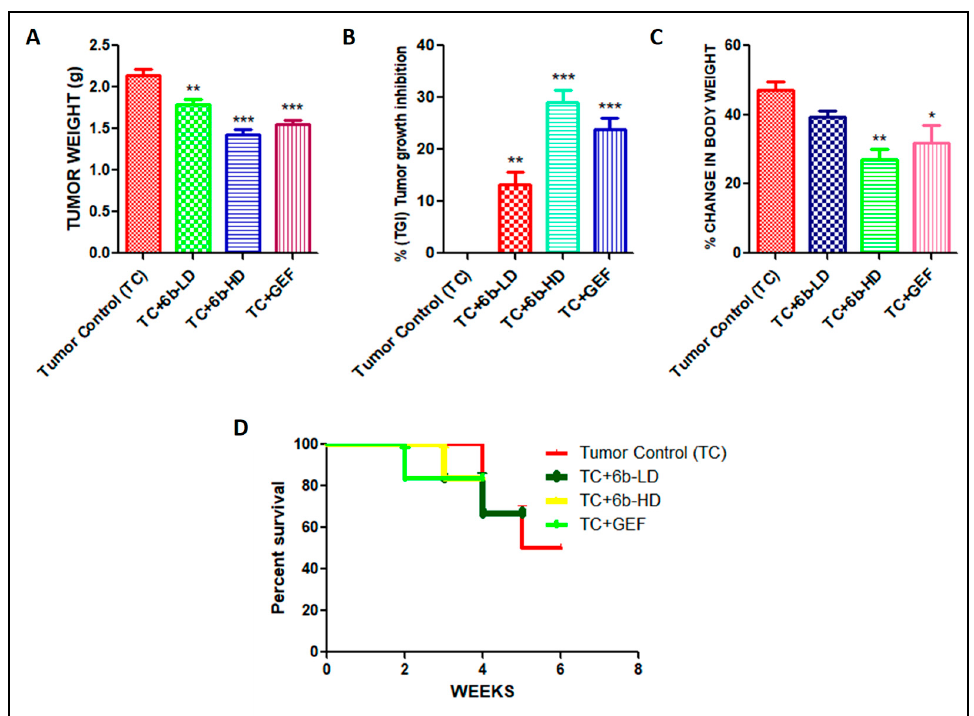
Figure 2. Effect of 6b and gefitinib treatment on the ( A ) tumor weight (g), ( B ) % tumor growth inhi- bition (TGI), ( C ) % body weight change, and ( D ) survival rate. All values are expressed as mean ± S.E.M. * p < 0.05, ** p < 0.01, *** p < 0.001 significant vs. tumor control (TC)